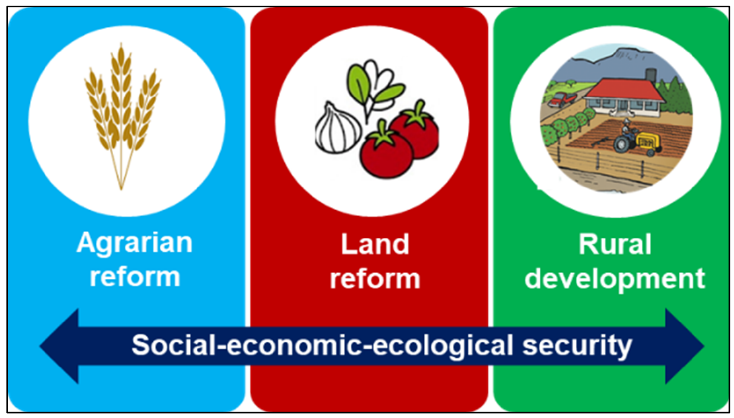
Figure 2. Interlinkages between land and agrarian reforms, and rural development for sustainable socio-economic and ecological security.